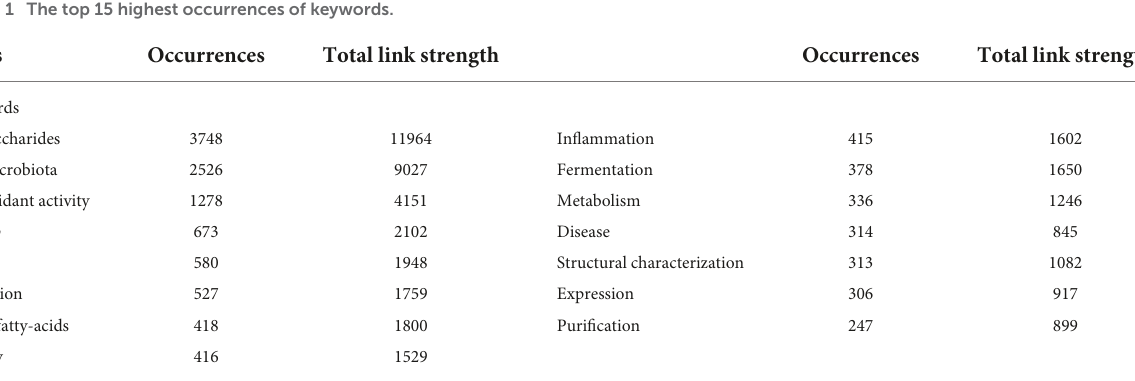
TABLE 1 The top 15 highest occurrences of keywords. Occurrences Total link strength Occurrences Total link